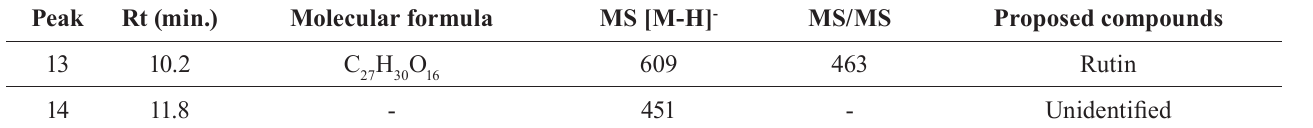
CP01: glycerin (GLY - 70%) and grain alcohol (GA - 30%); CP02: propylene glycol (PG - 70%) and grain alcohol (GA - 30%); Rt: retention